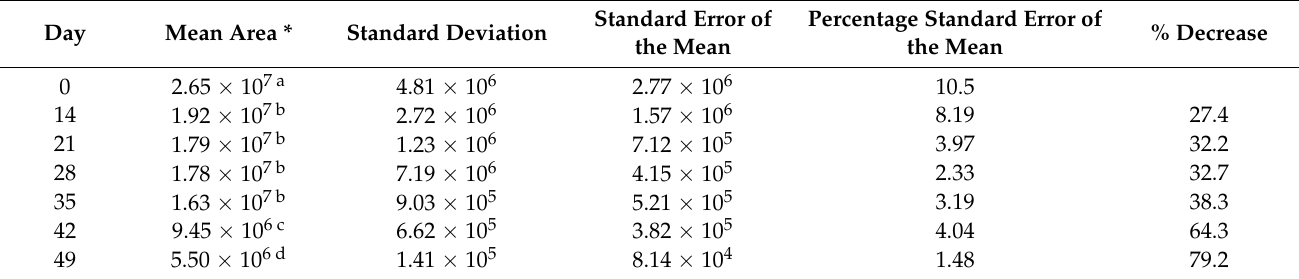
Table 2. Persistence interval of A. mexicana essential oil.